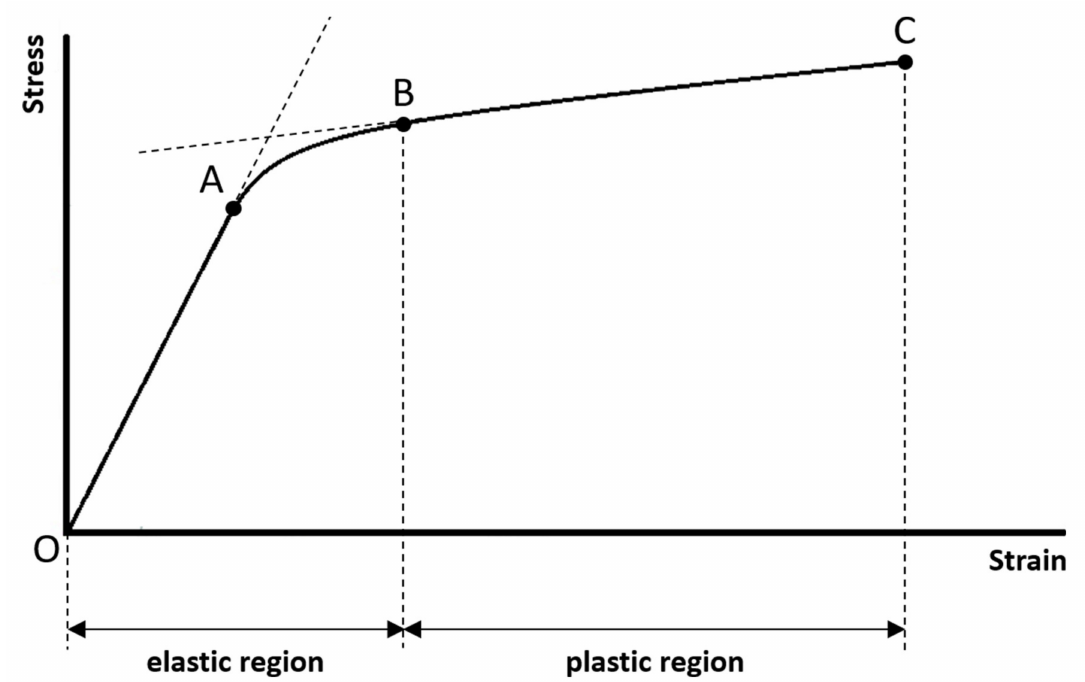
Figure 2. The typical stress–strain curve of compact bone measured using uniaxial tensile test until failure. Two regions (elastic and plastic regions) and four points (points O, A, B, and C) that have significant mechanical meanings are